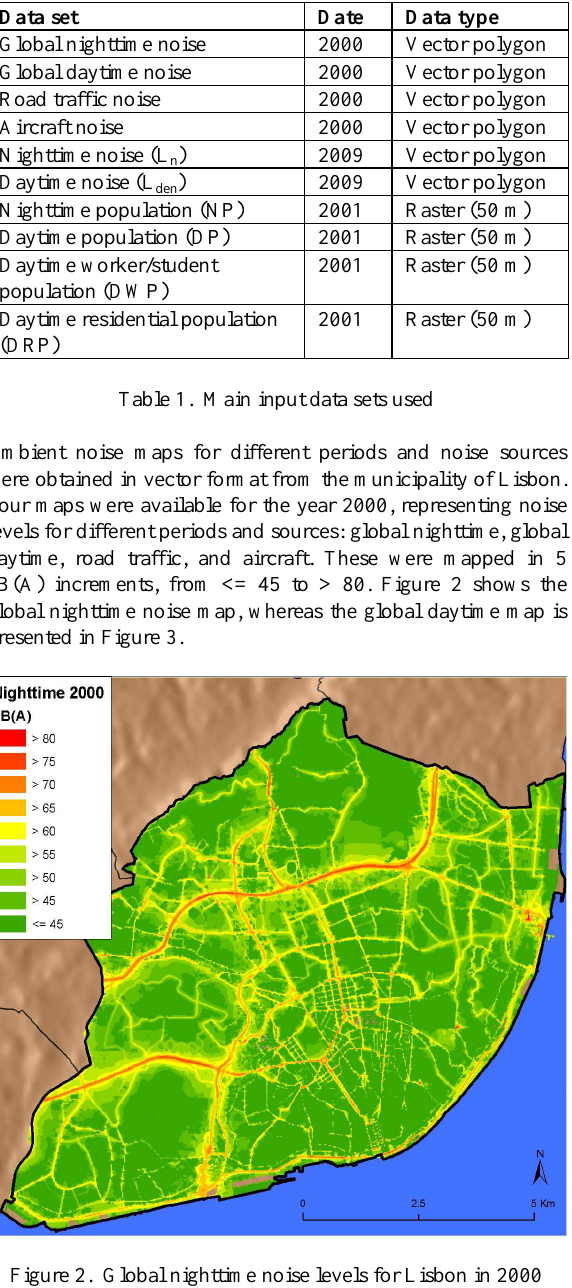
Figure 2. Global nighttime noise levels for Lisbon in